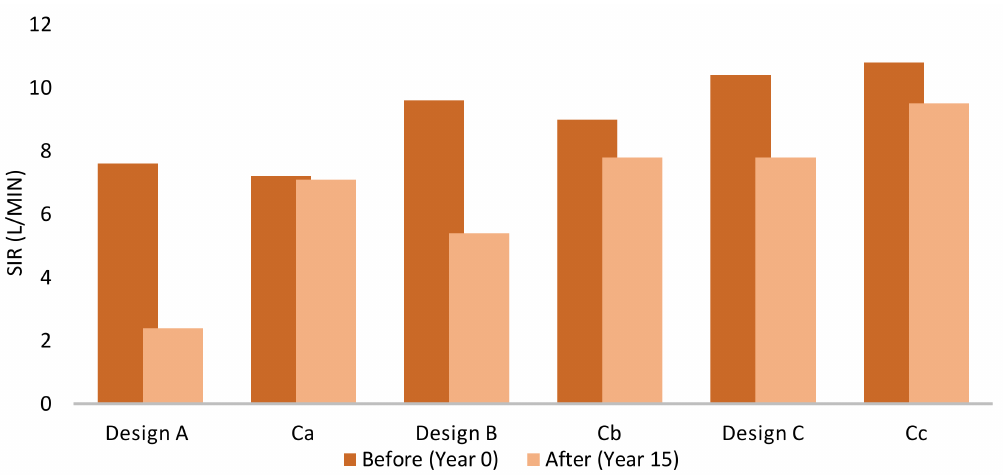
Figure 7. The average SIR before and after 15 years’ stormwater and sediment application (Cycle 2).